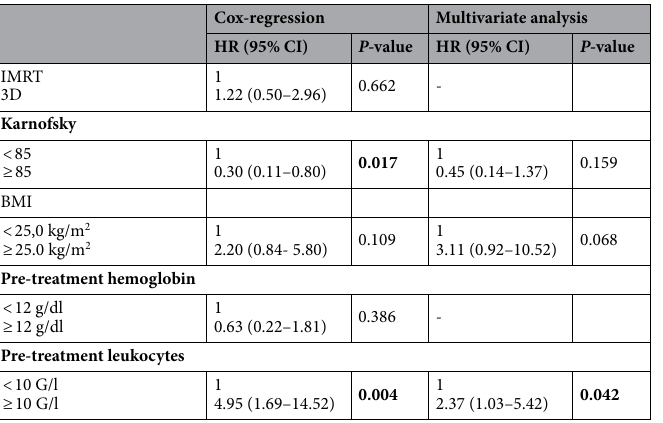
Table 4. Uni- and multivariate analysis. Cox-Regression: 5-year overall survival (OS), disease-free survival (DFS), colostomy-free survival (CFS); HR Hazard Ratio; 95% CI confidence interval. significant values are in